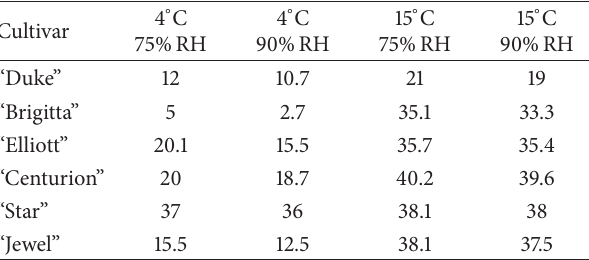
Table 2: Percentages (%) of dehydrated fruits take into account visually surface dehydration at different storage conditions of temperature ( ∘ C) and relative humidity (RH) after 21 days of storage.